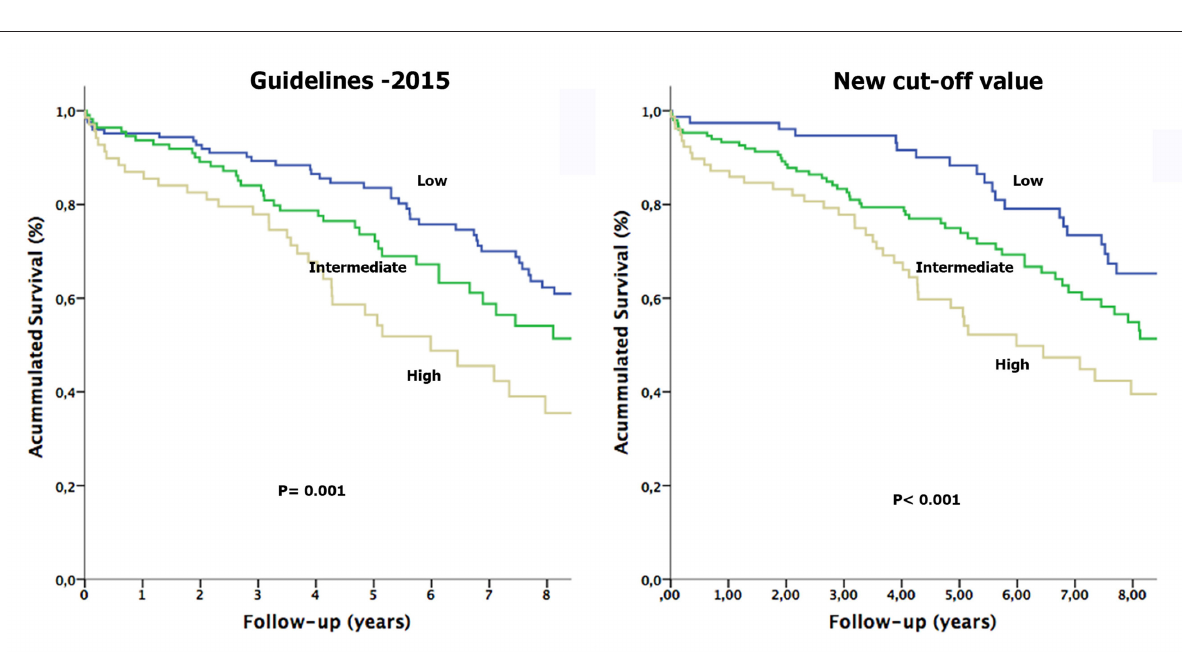
up to r = 0.40 ( p < 0.001) in moderate TR. Regarding RV diameter, while no association with TRV was found in mild TR, a moderate correlation was observed ( r = 0.38, p = 0.001) in moderate